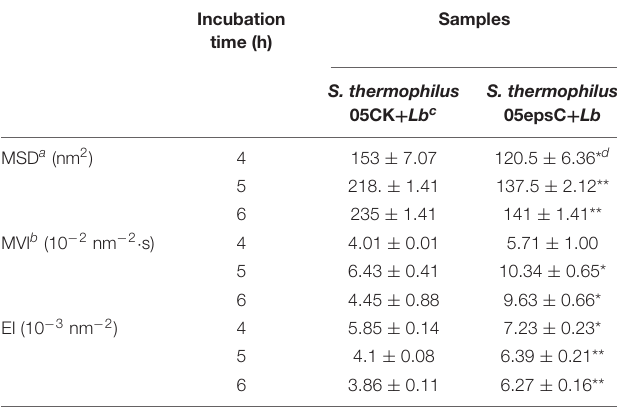
TABLE 3 | The MSD, macroscopic viscosity index, and elasticity index of yogurt produced by S. thermophilus 05epsC or 05CK at 4, 5, and 6